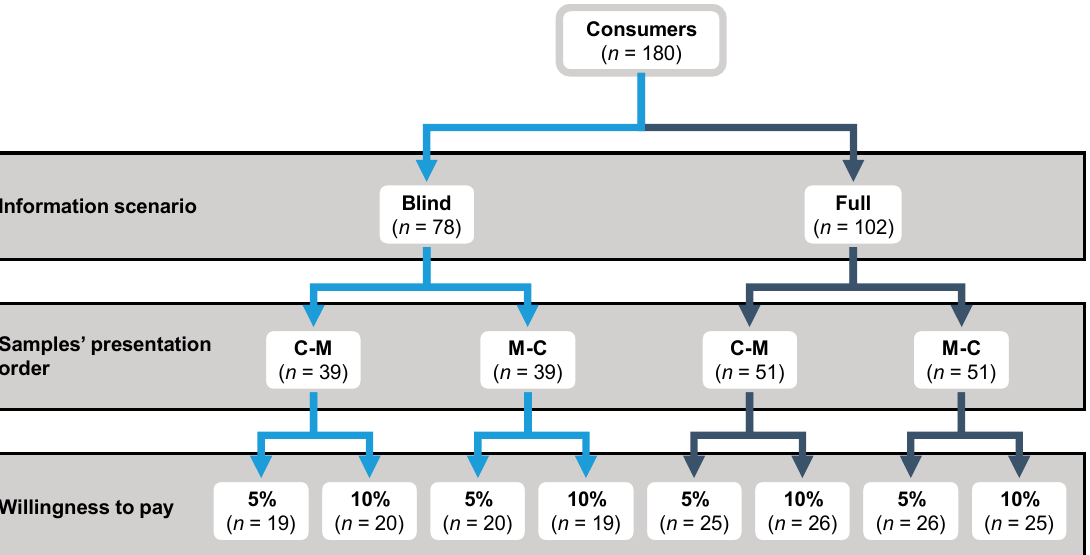
Figure 1. Experimental design used in the present study ( C : conventional patty; M : modified patty). Information scenario: Blind : disclosure of details of the meat origin, Full : disclosure of details of the meat origin and the ingredients used to enrich the patties in n-3 polyunsaturated fatty acids (PUFA) and vitamin D 3.